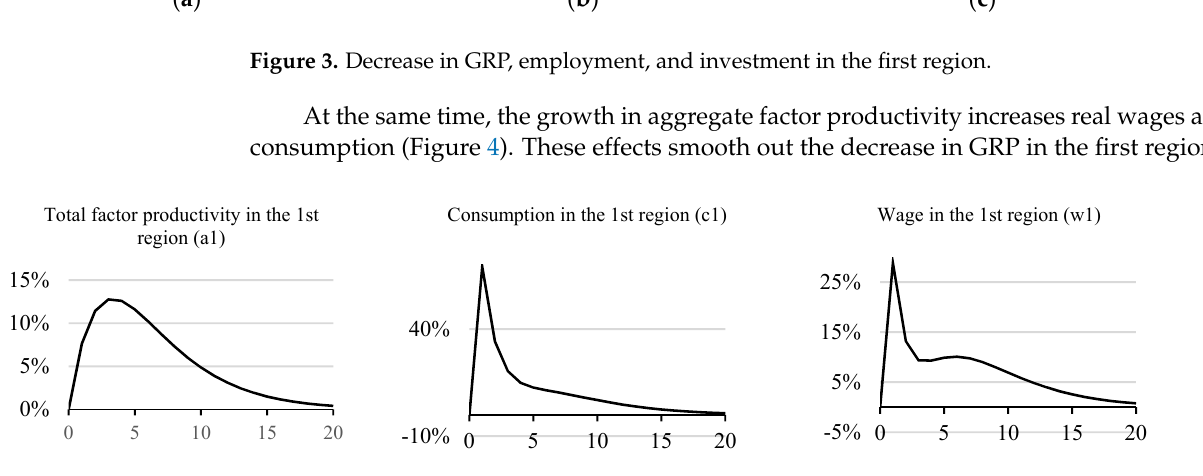
Figure 4. Decrease in total factor productivity, consumption, and wages in the first region. The interest rate (Figure 5) initially decreases (which also supports consumption) against the background of a decrease in demand for fixed assets. However, then, as in- vestment activity recovers and aggregate factor productivity increases, it grows above the equilibrium level.